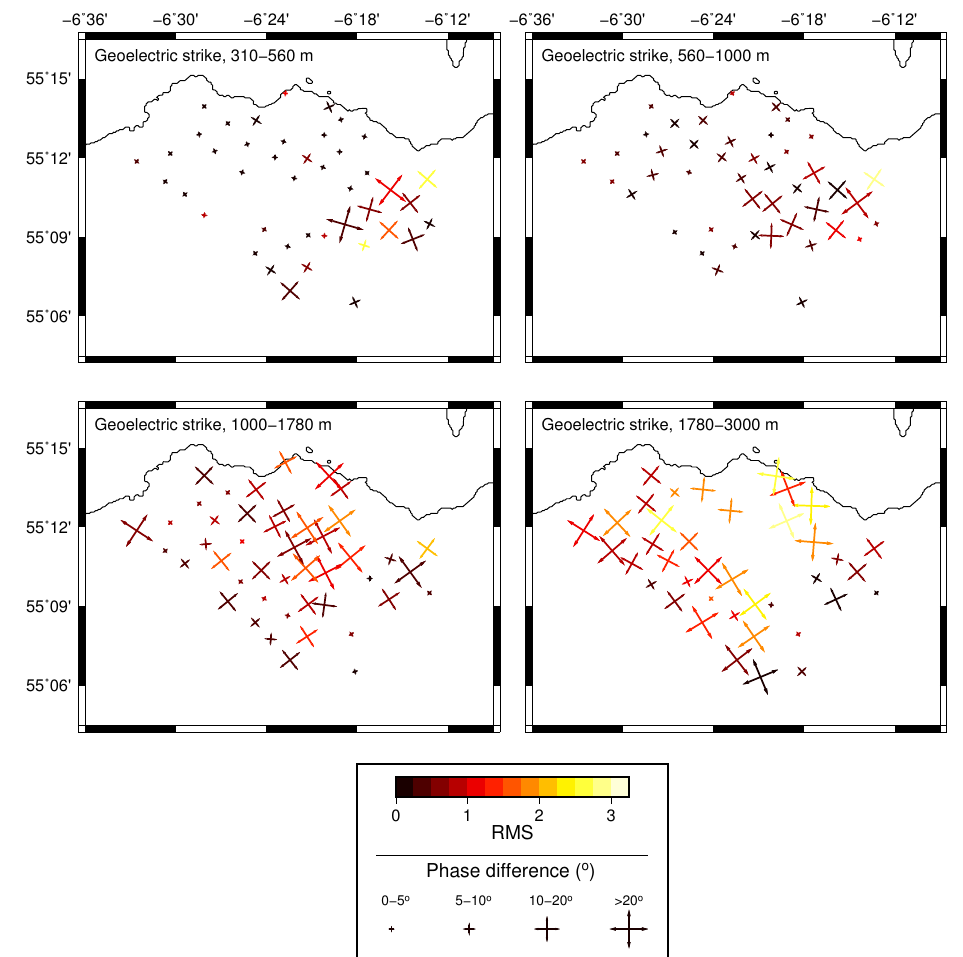
Figure 4. Visualisation of dimensionality of MT data, decomposed using the “strike” analysis program McNeice and Jones (2001) over a range of depth bands (in metres below sea level). The orthogonal vectors at each MT site location indicate the azimuth of best-fitting geoelectric strike direction, coloured by the rms misfit between the observed MT response and the Groom–Bailey model response for the best-fit strike direction. The orthogonal pair of vectors is required as geoelectric strike estimates have a 90 ◦ ambiguity. The size of orthogonal vectors is classified by the phase difference, with larger vectors corresponding to larger phase differences. Small phase differences are associated with 1-D resistivity structure, whereas larger phase differences occur with a 2- and 3-D structure. Larger rms misfits indicate that the decomposition to a 2-D structure is potentially invalid and can be caused by either significant noise contamination and distortion of the data or a 3-D